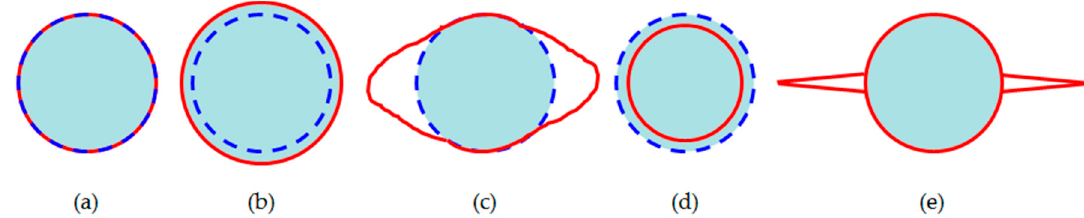
Figure 1. Typical wellbore instability. ( a ) Stable borehole; ( b ) Enlarged borehole; ( c ) Borehole breakout; ( d ) Restricted borehole; ( e ) Borehole fracture.